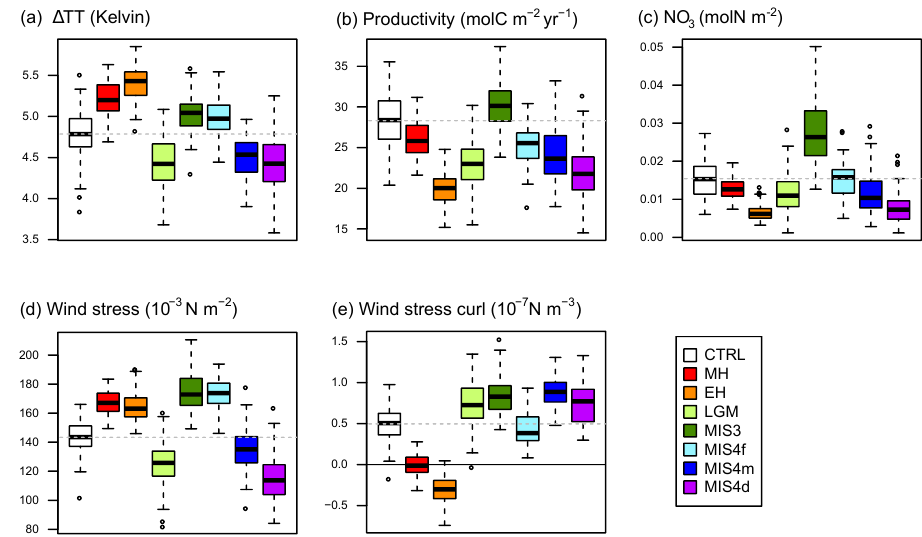
Figure 9. Box plots of summer (JJAS) (a) (cid:49) TT (K) values, coastal Arabian Sea (b) productivity (molCm − 2 yr − 1 ) integrated over the whole water column, (c) nitrate concentration (molNm − 2 ) in the first 30m, (d) wind stress intensity (10 − 3 Nm − 2 ) and (e) wind stress curl intensity (10 − 7 Nm − 3 ) for all eight simulations. Dashed grey line indicates the CTRL value for each variable. The simple black line in (e) panel indicates the zero value. The box plots highlight the median value (bold line), the first and the third quartiles (lower and higher limits of the box), and the 95% confidence interval of the median (upper and lower horizontal dashes). The dots are extreme values that happened during the 100 years of